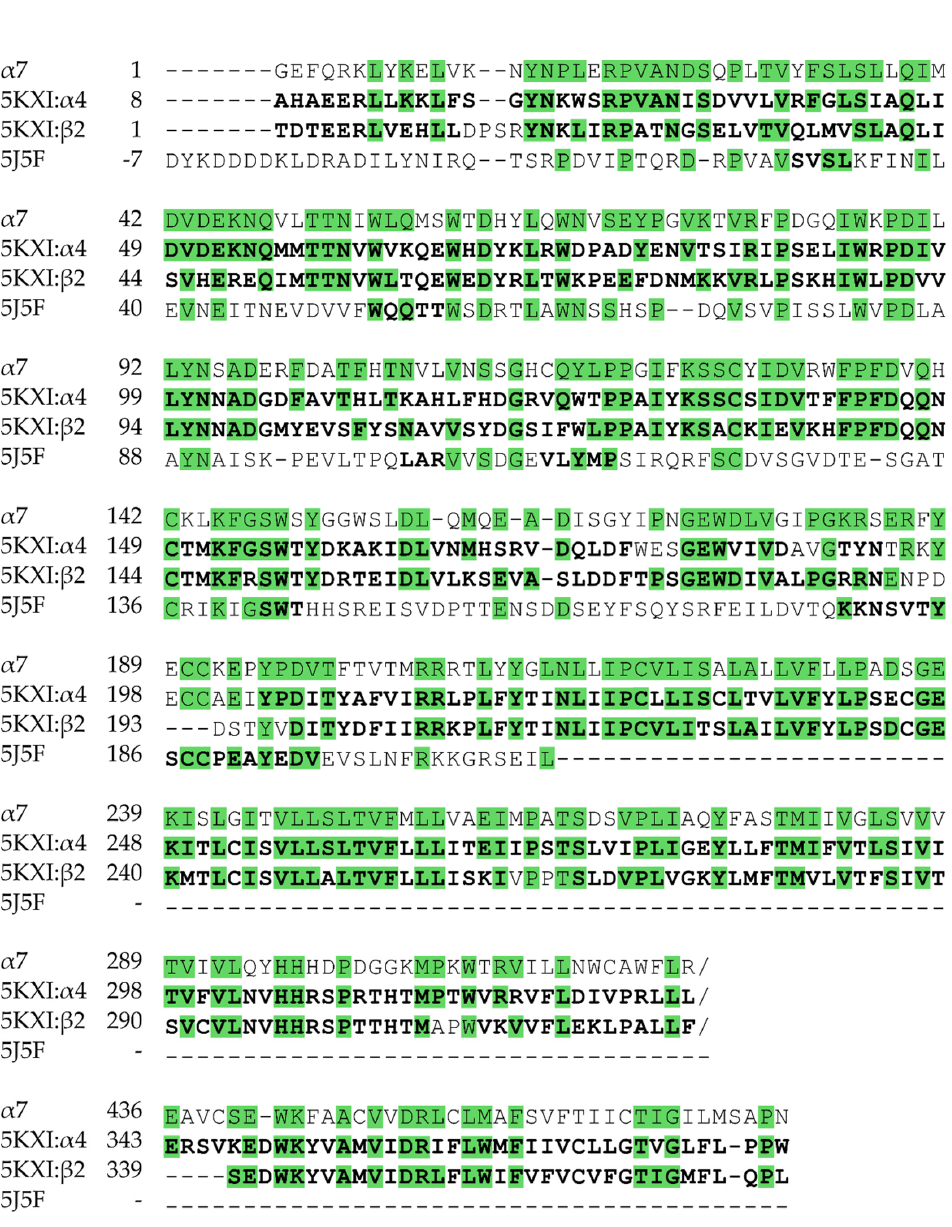
Figure 10. Sequence alignment of the templates used in the homology model of α 7 nAChR. The sequence of one α - and one β -subunit of the ( α 4) 2 ( β 2) 3 receptor co-crystallized with nicotine (PDB 5KXI) and of an AChBP co-crystallized with Compound 44 ( 5 ) were aligned using T-Coffee and modified for homology model building. Residues used as templates in homology modelling are shown in bold and conserved amino acids highlighted green. The overall sequence identity between the α 7 nAChR and the ( α 4) 2 ( β 2) 3 nAChR subunits used as primary templates are 45% (62% sequence similarity) and 37% (57% sequence similarity), respectively. The sequence identity between α 7 nAChR and AChBP is 28% (46% sequence similarity) overall and 39% (64% sequence similarity) for the part that was used as template.